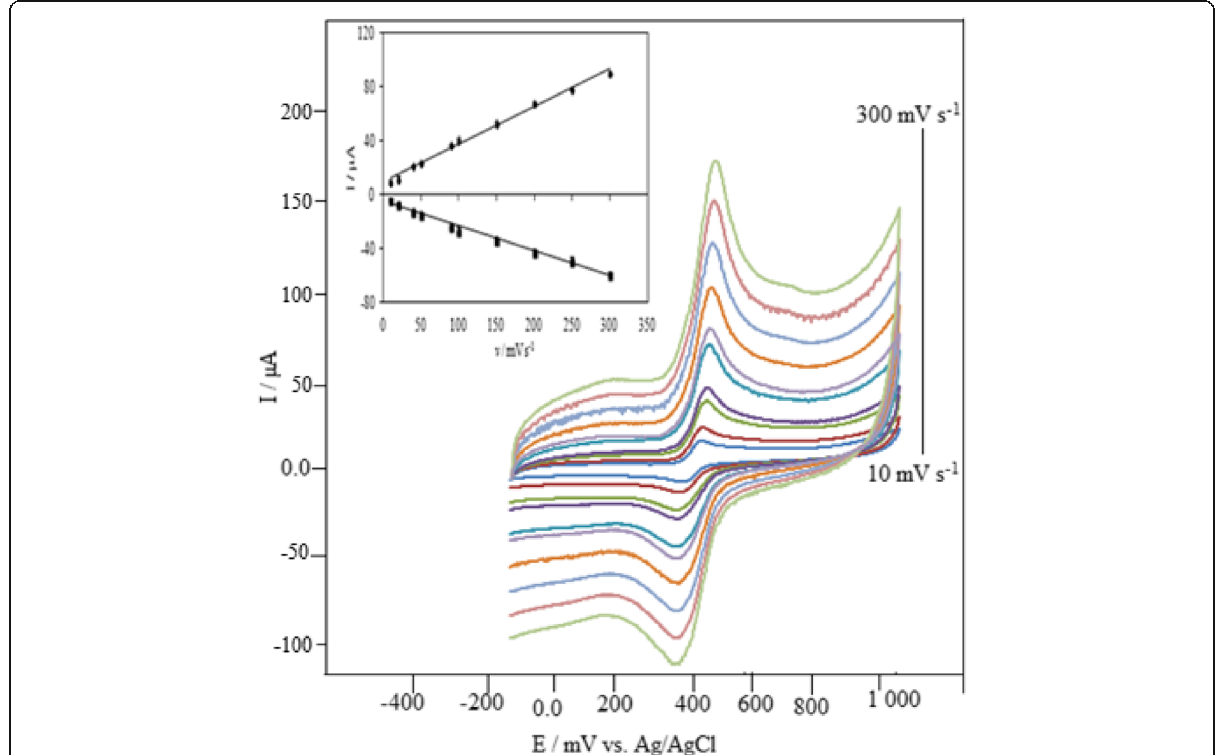
Fig. 8 CVs acquired on B 2 O 3 /MWCNT/GCE with 0.1 mM paracetamol in 0.1 M PBS, pH 4 at different scan rates from 10 to 300 mV s − 1 . Inset is the plot of the I pa of paracetamol vs.